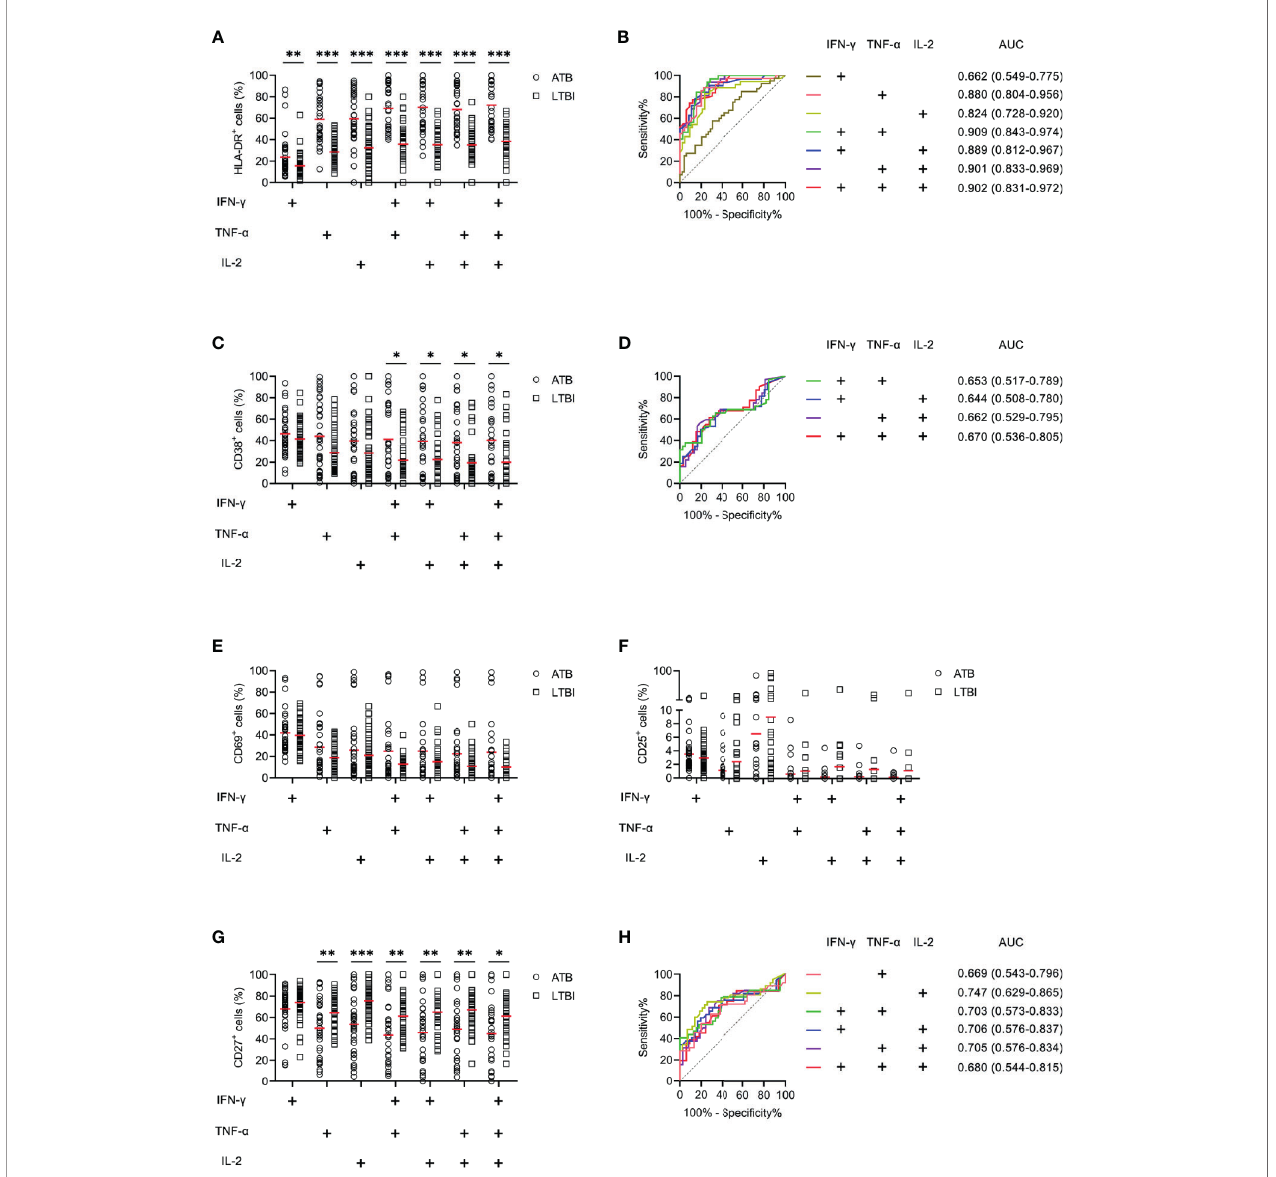
FIGURE 4 | The performance of activation markers on MTB-speci fi c CD4 + T cells in distinguishing ATB patients from LTBI individuals in Qiaokou cohort. (A) Aligned dot plots showing the results of HLA-DR expression on MTB-speci fi c cells in ATB patients and LTBI individuals. Horizontal lines indicate the medians. (B) ROC analysis showing the performance of HLA-DR expression on MTB-speci fi c cells in discriminating ATB patients from LTBI individuals. (C) Aligned dot plots showing the results of CD38 expression on MTB-speci fi c cells in ATB patients and LTBI individuals. Horizontal lines indicate the medians. (D) ROC analysis showing the performance of CD38 expression on MTB-speci fi c cells in discriminating ATB patients from LTBI individuals. (E) Aligned dot plots showing the results of CD69 expression on MTB-speci fi c cells in ATB patients and LTBI individuals. Horizontal lines indicate the medians. (F) Aligned dot plots showing the results of CD25 expression on MTB-speci fi c cells in ATB patients and LTBI individuals. Horizontal lines indicate the medians. (G) Aligned dot plots showing the results of CD27 expression on MTB-speci fi c cells in ATB patients and LTBI individuals. Horizontal lines indicate the medians. (H) ROC analysis showing the performance of CD27 expression on MTB-speci fi c cells in discriminating ATB patients from LTBI individuals. * P < 0.05, ** P < 0.01, *** P < 0.001 (Mann-Whitney U test). MTB, Mycobacterium tuberculosis ; ATB, active tuberculosis; LTBI, latent tuberculosis infection; AUC, area under the